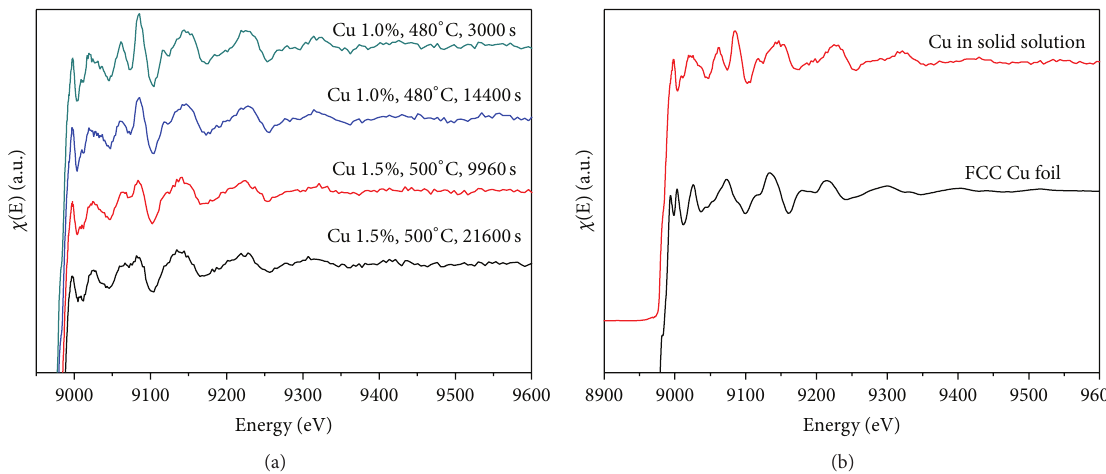
Figure 4: The XAS spectra of (a) Cu-added samples after different ageing treatments, compared with (b) standard Copper foil and solution annealed sample.